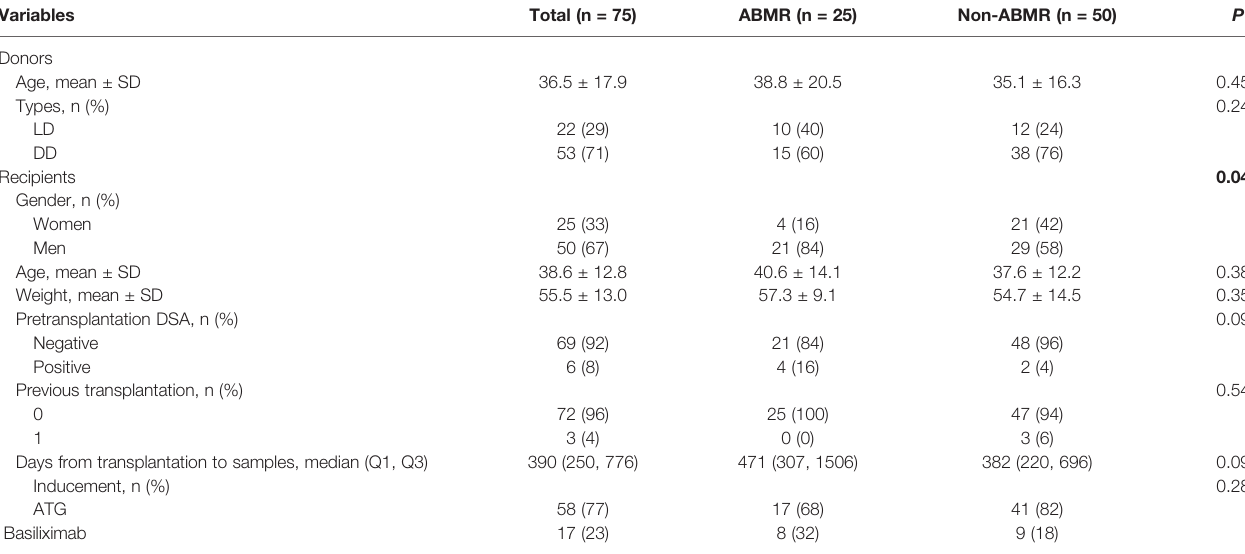
TABLE 1 | The demographics and clinical characteristics of kidney transplant recipients and donors in the diagnostic study.